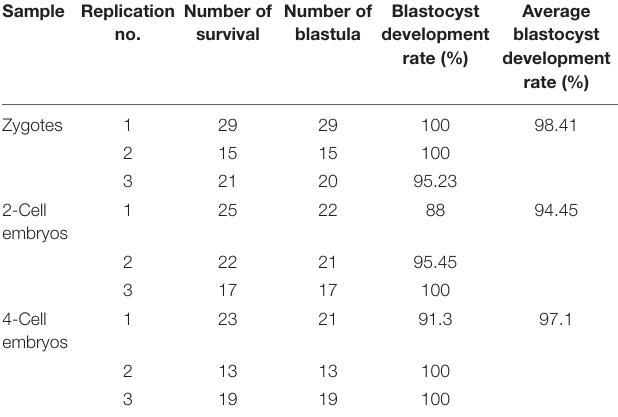
TABLE 2 | Statistics of blastocyst development results. Sample Replication no.